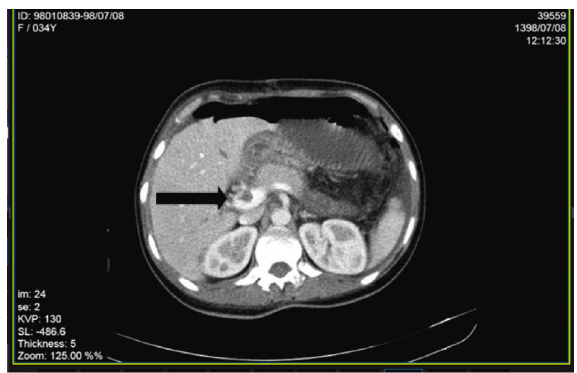
Figure 3: Thrombosis in main portal vein with its extension to right and left intrahepatic branches in spiral abdominal CT scan with IV contrast (black